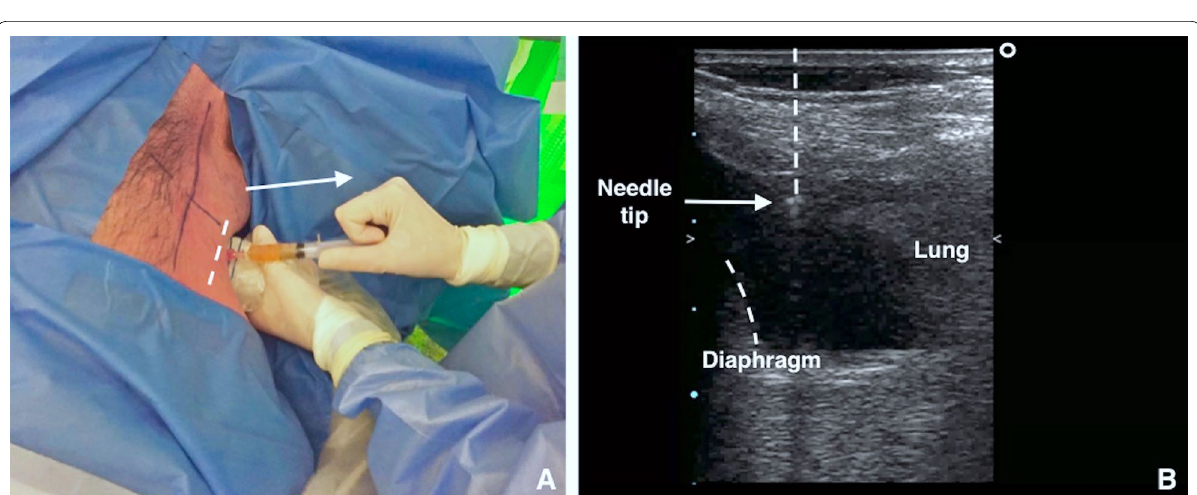
Fig. 4 A Using the high-frequency US transducer (linear probe) in the transverse position, the puncture is performed employing short axis ultrasound-guidance (out of plane technique) at the point previously identified. Aspiration of fluid with a syringe confirms correct position of the needle tip. B With direct needle guidance, the correct position of the needle tip is visualised in real-time and is monitored